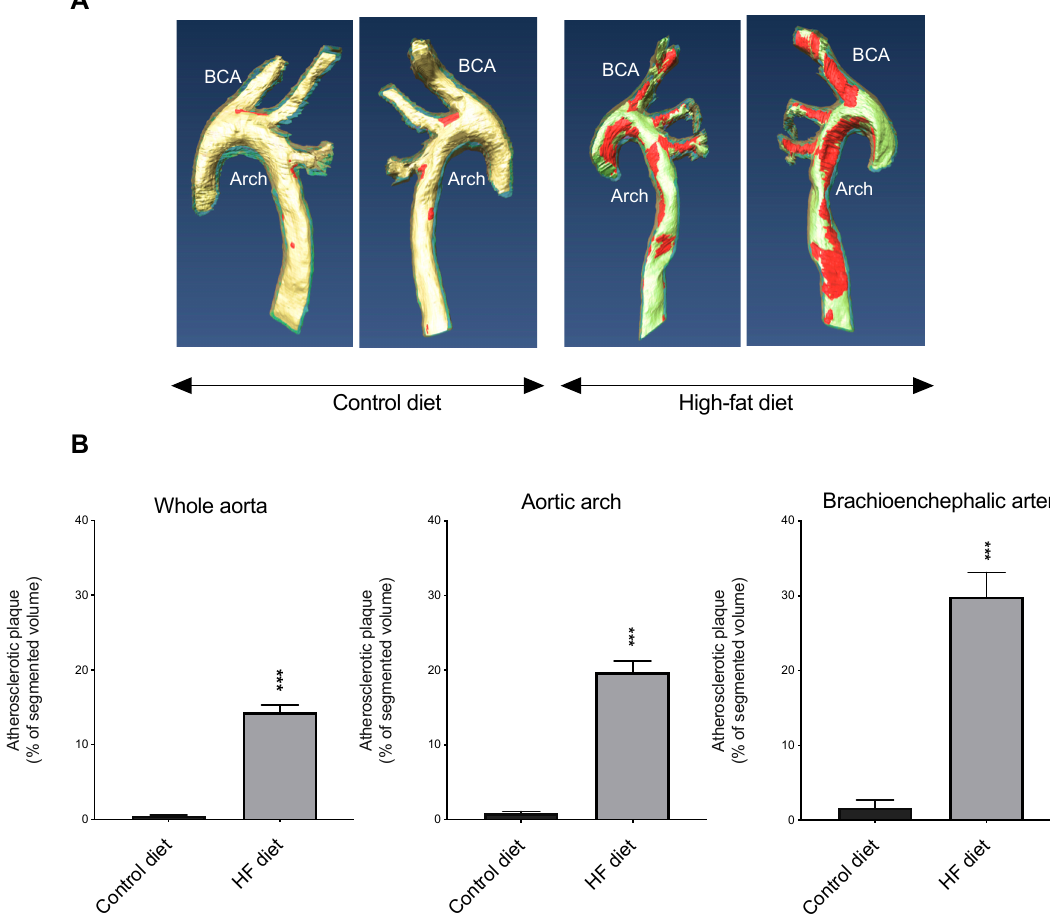
Figure 5. Differences in aortic atherosclerosis burden between mice fed the different diets. ( A ) Representative images (both sides of the same aorta are shown) of the visualization of the arteriosclerotic plaque (colored in red) using 14T-magnetic resonance imaging (MRI) in aortas from mice fed control or high-fat diets (BCA, brachiocephalic artery). ( B ) 14T-MRI volumetric assessment of the atherosclerotic plaque in different aorta segments. Data shown are the mean ± SEM (n = 8–10 per group). *** p < 0.001, HF versus control.